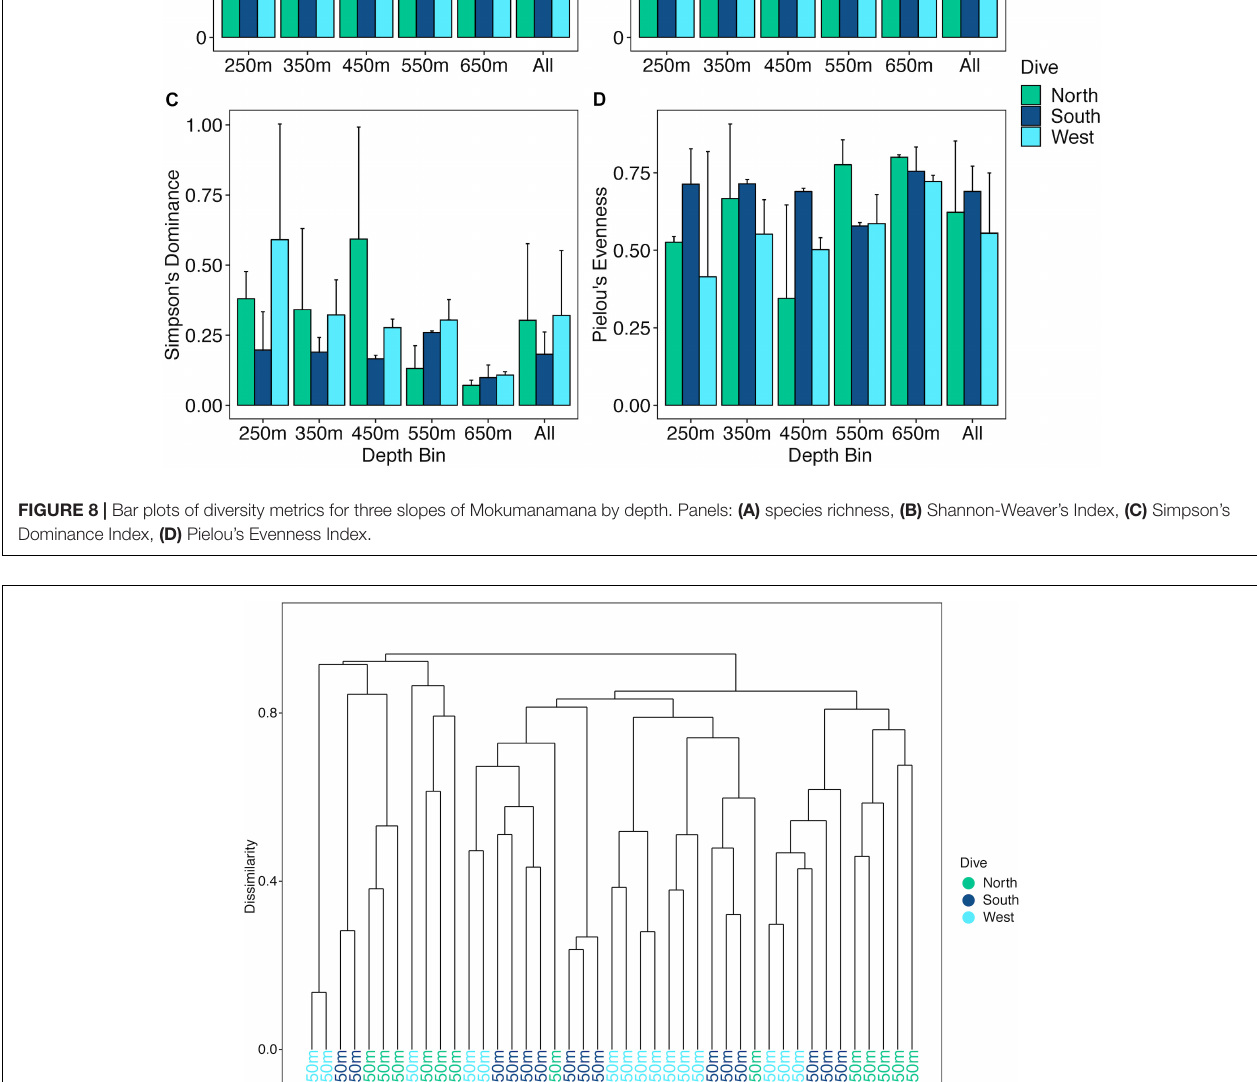
that the species turnover was not defined as a loss of species richness but rather a replacement of species with changes in depth. Within a depth bin, beta diversity was also high between the three sides of Mokumanamana